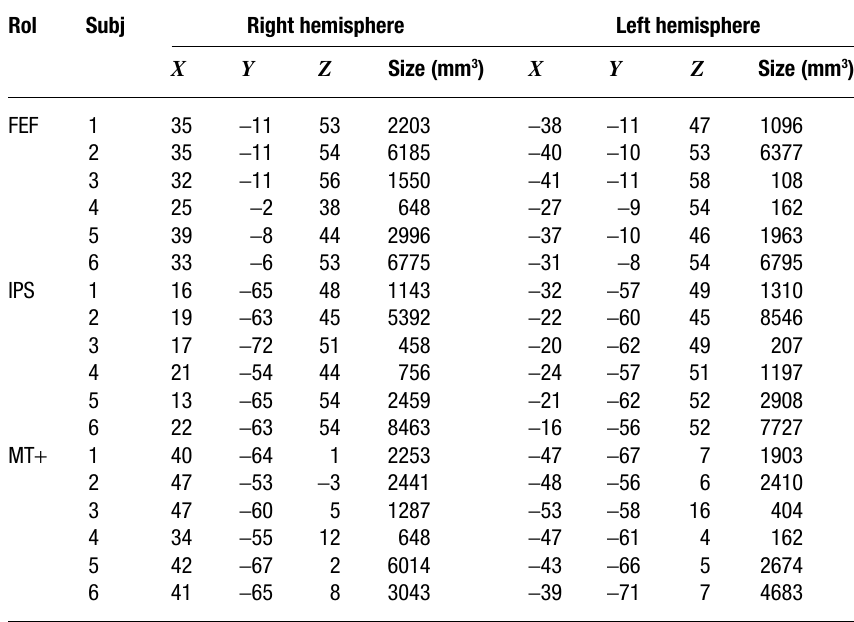
Table 1. Individual fMRI regions of interest. Rol Subj Right